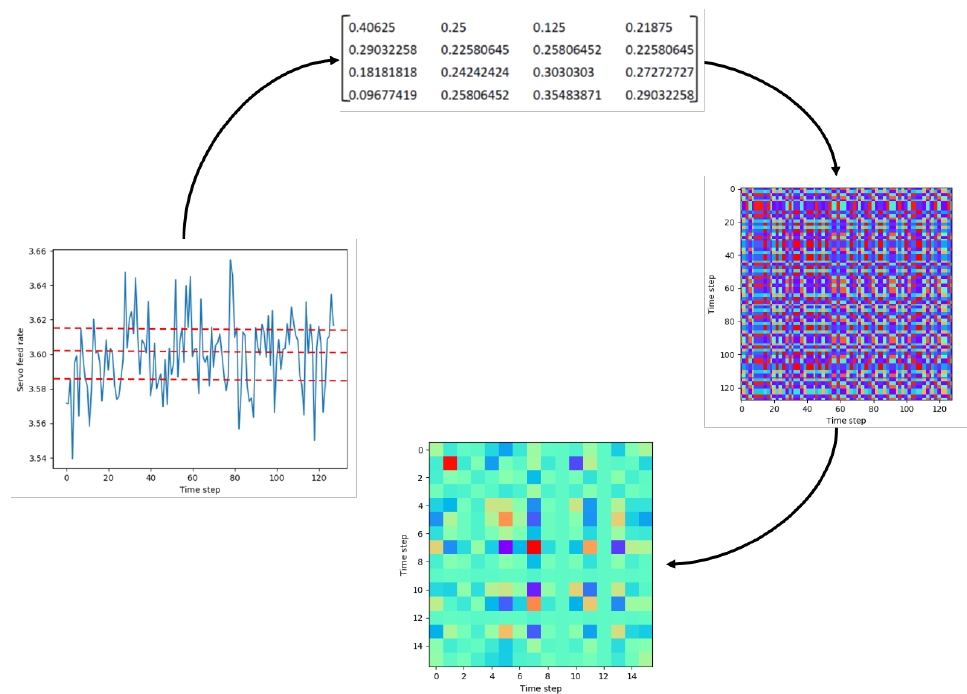
Figure 7. The process of transforming a time series into a Markov transition field: ( left ) time series and different states, ( top ) Markov transition matrix, ( right ) Markov transition field, and ( bottom ) blurred Markov transition field.